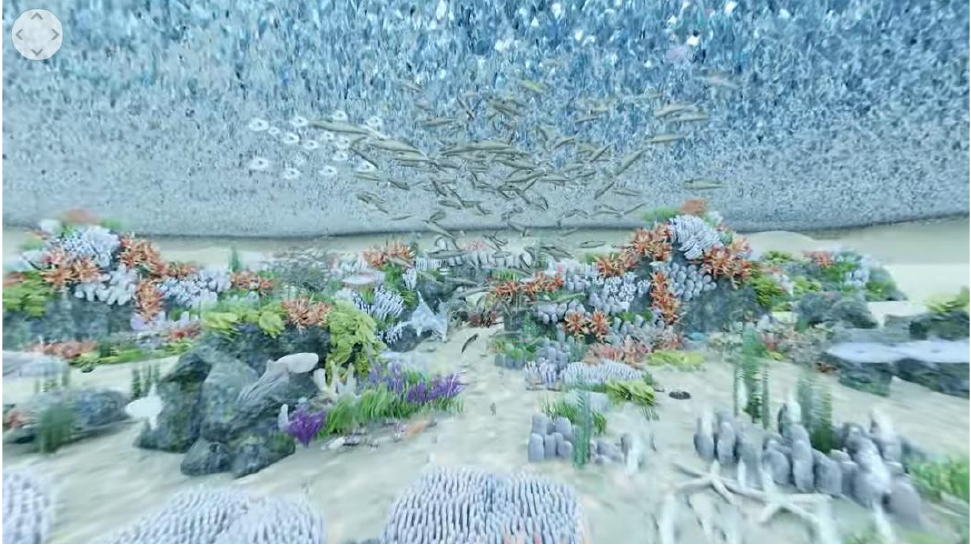
Figure 10. A frame from the animation of the Jurassic paleoenvironment modeled.